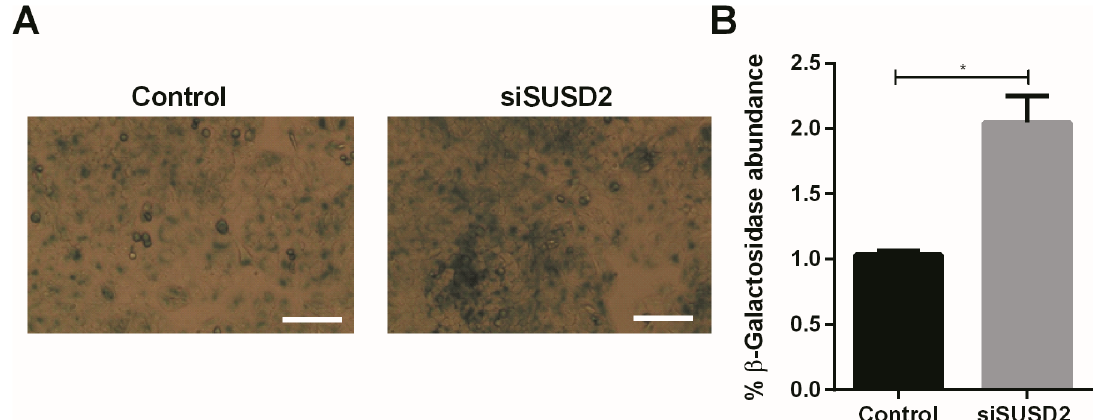
Fig 3. Influence of SUSD2 knockdown on cell senescence. (A) Representative pictures of Ishikawa cells stained for β - Galactosidase after SUSD2 knockdown. Scale bar 100 μ m.(B) Arithmetic means ± SEM (n = 3–8) of relative abundance of β - Galactosidase. * P < 0.05 indicatesstatistically significantdifference from control cells using Student’s t-test.